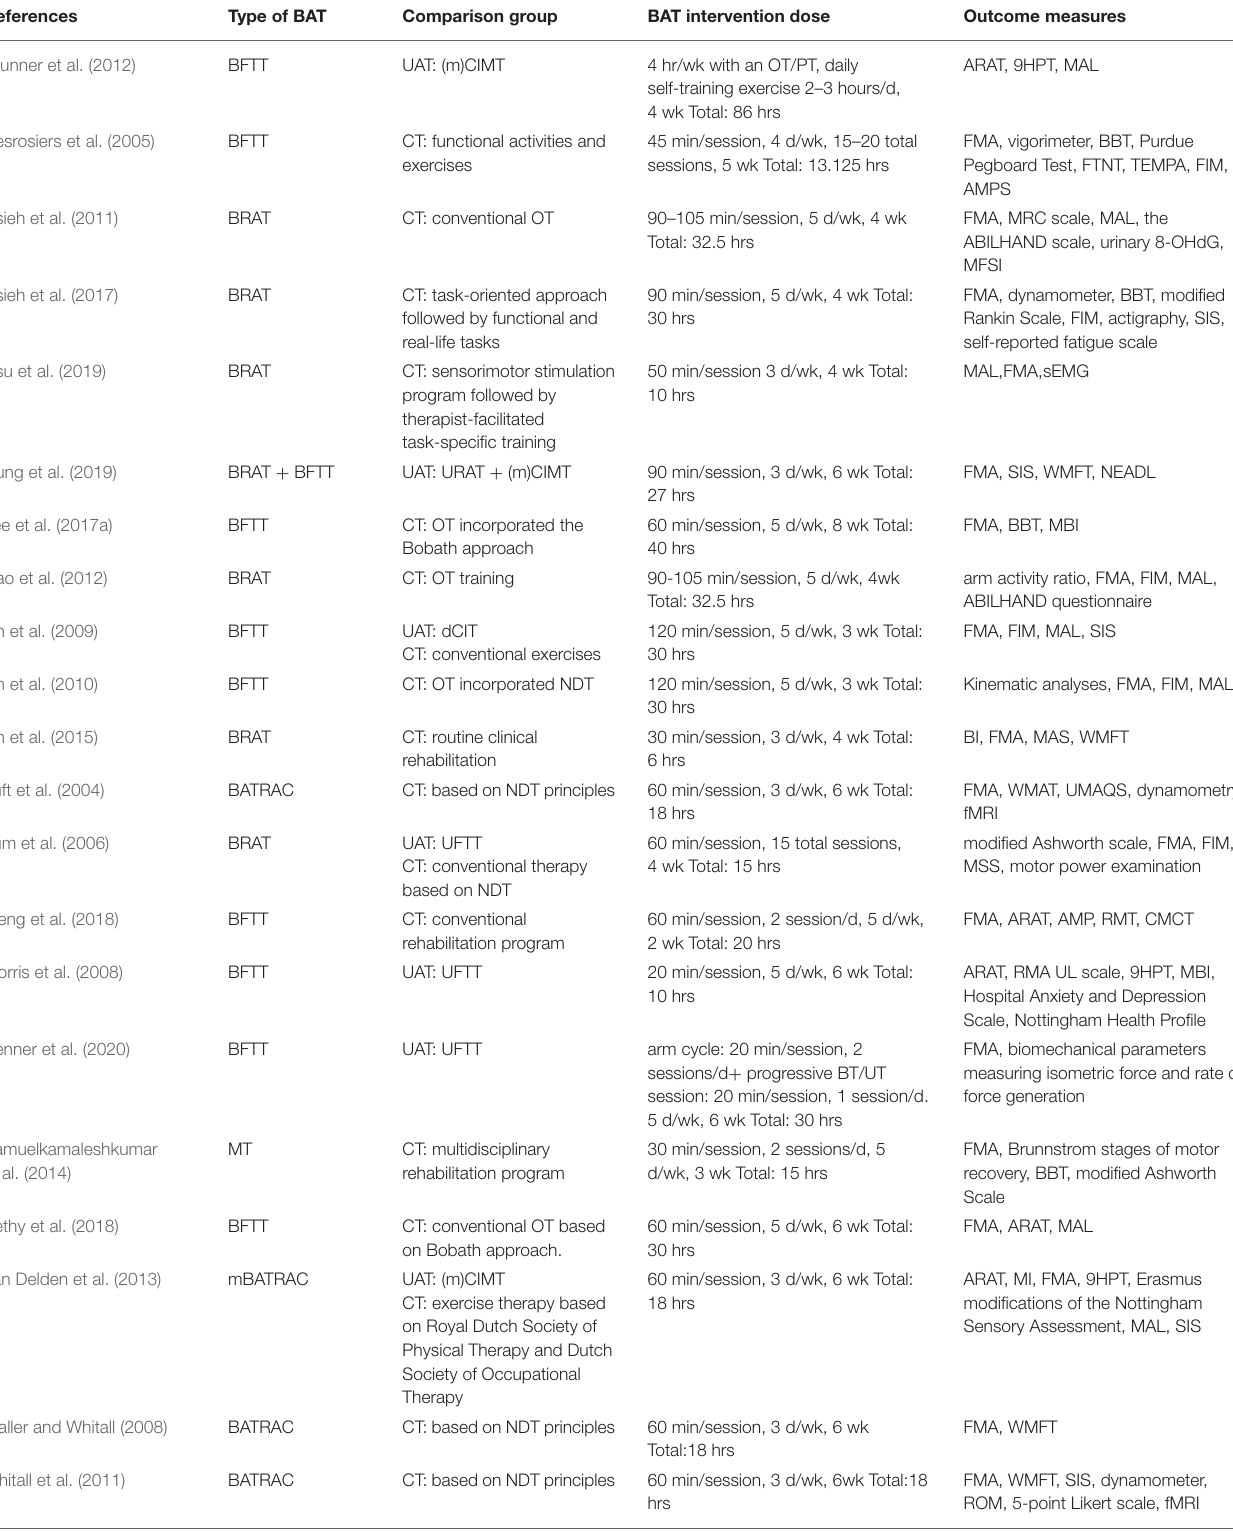
TABLE 2 | Characteristics of the included studies in this